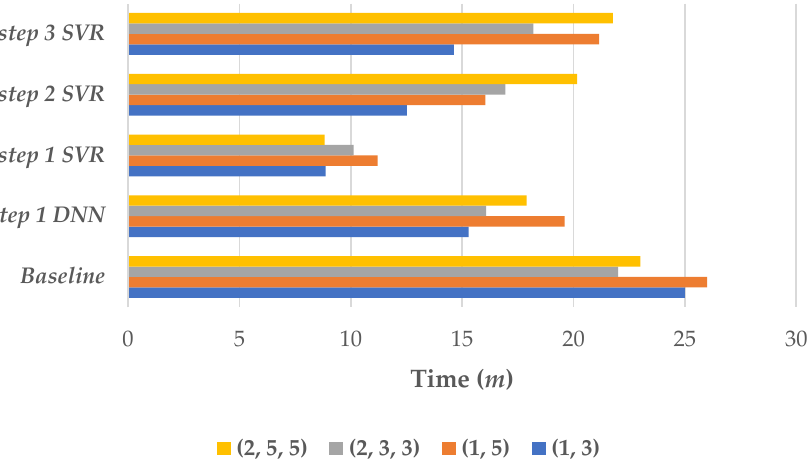
Figure 8. Figure 8. Calculation times of the baseline DDQN and the proposed SGAs for cart-pole balancing optimization.